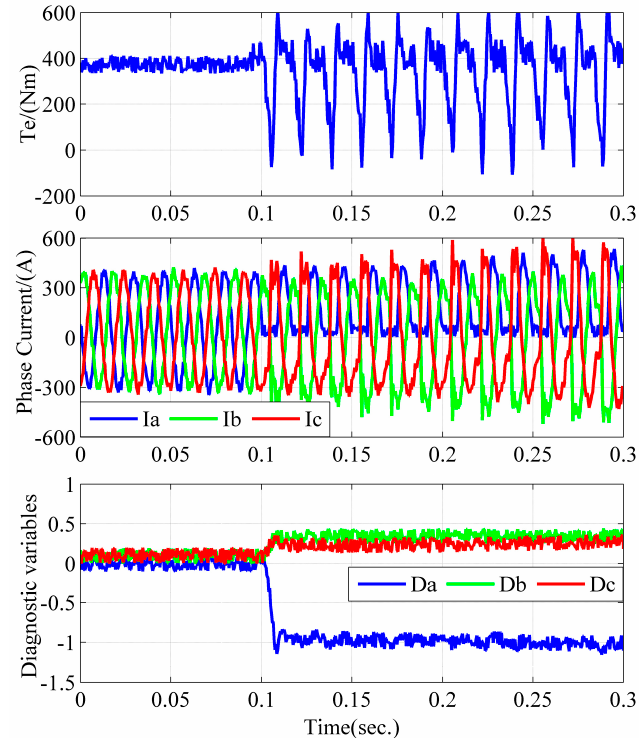
Figure 14. Experimental results at 600 rpm/358 Nm.